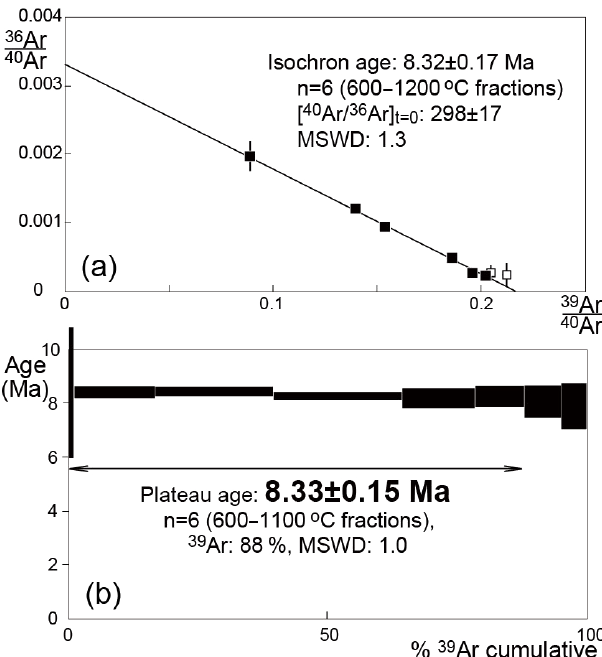
Figure 7. (a) Inverse isochron and (b) 40 Ar / 39 Ar age spectrum. MSWD: mean-squared weighted deviation (MSWD = SUMS / ( n − 2); York, 1968). All errors are 2 σ